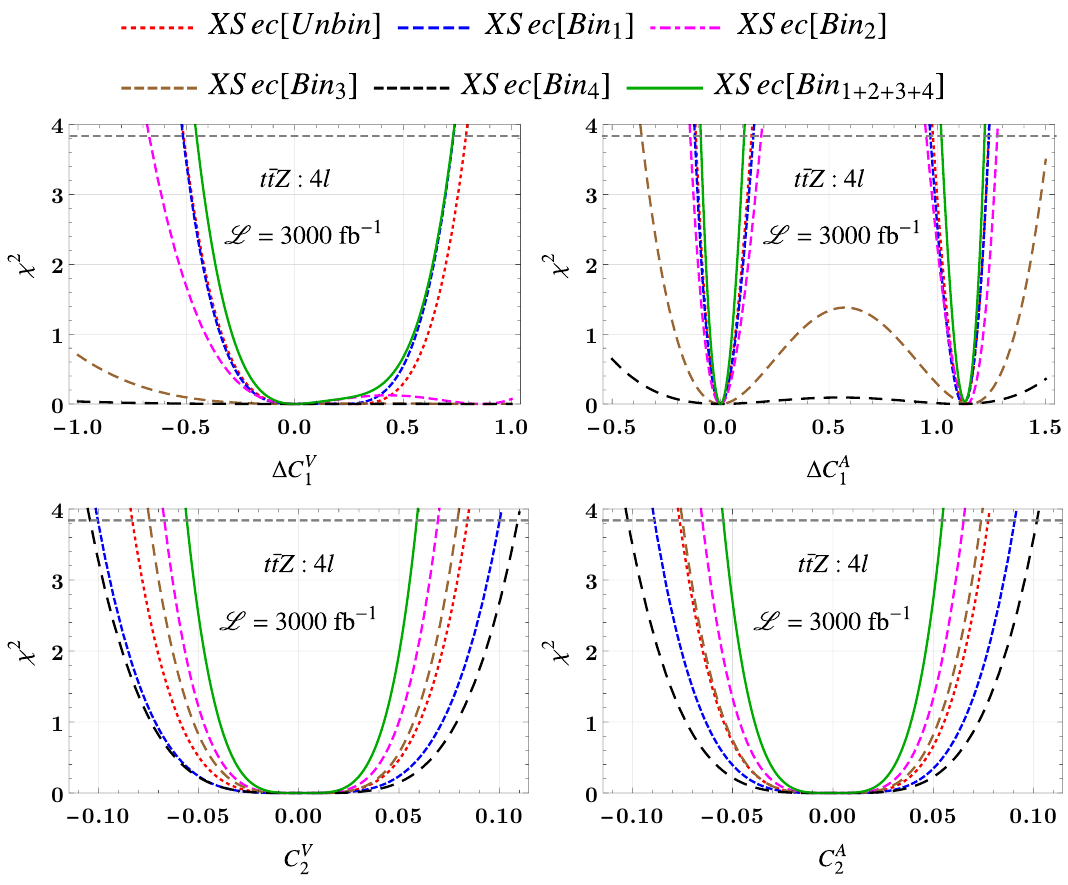
Figure 12 . Comparison of the total un-binned cross section with the binned cross sections (binned in p ( Z ) , see eq. (4.6)) in terms of χ 2 as a function of t ¯ tZ anomalous couplings at T and integrated luminosity of L = 3000 fb − 1